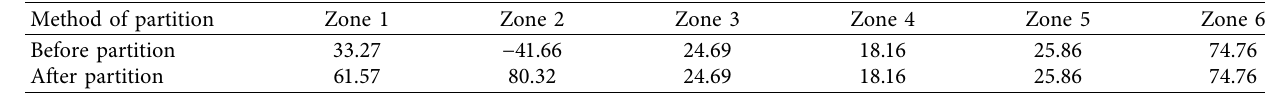
Table 3: Verification results of reactive power reserve.